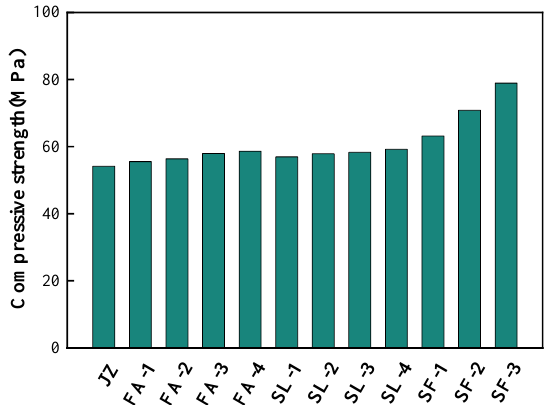
Figure 3. 28 d compressive strength of cement mortar.